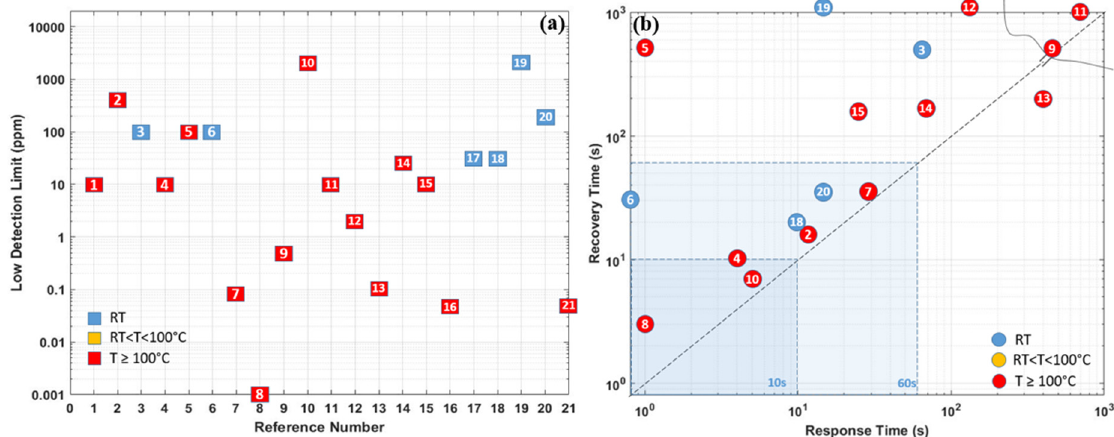
Figure 35. Regarding Table 2, schematic illustrations of the comparison of the reported: ( a ) low detection limits. The x-axis “Reference Number” represents the 1 st column“Ref. Nr.“ in Table 2. ( b ) Response time/recovery time under experimental conditions in the literature.